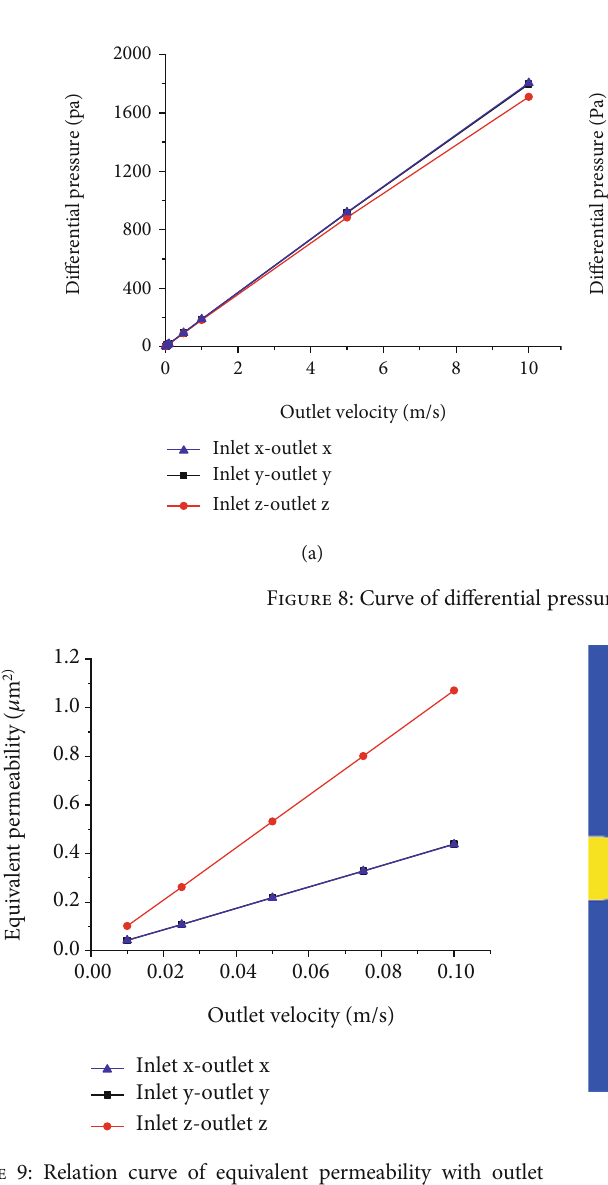
Figure 9: Relation curve of equivalent permeability with outlet velocity.